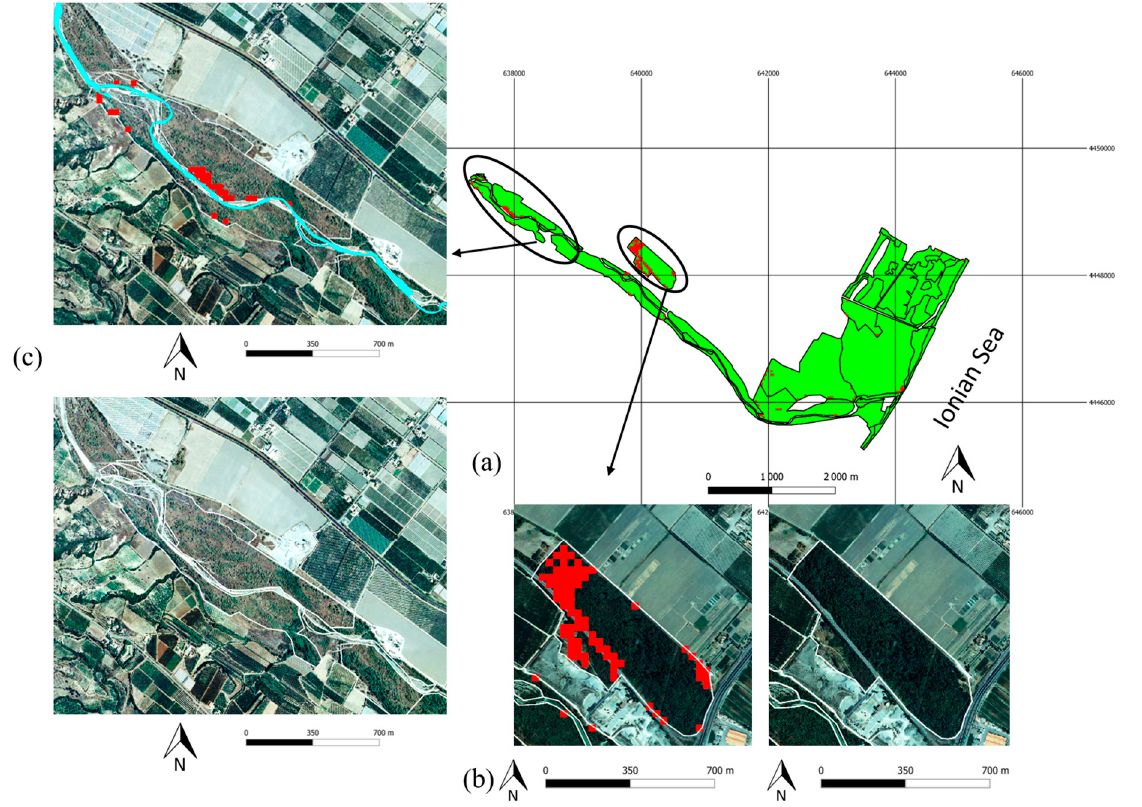
Figure 9. Bosco Pantano di Policoro SAC: ( a ) Map of relative anomalies (2009); zoom of negative anomalies superimposed on the orthophoto within ( b ) habitat 91F0 ( Riparian mixed forests of Quercus robur. Ulmus laevis and Ulmus minor, Fraxinus excelsior, or Fraxinus angustifolia, along the great rivers ), associated with the fragmented structure of vegetation patches due to salinization phenomena and invasion of halophytic species; ( c ) habitat 92D0 with 1410 ( southern riparian galleries and thickets with Mediterranean salt meadows—Juncetalia maritime ) as a consequence of hydrological oscillations in water regime (the Sinni River, in cyan, crosses the habitat).